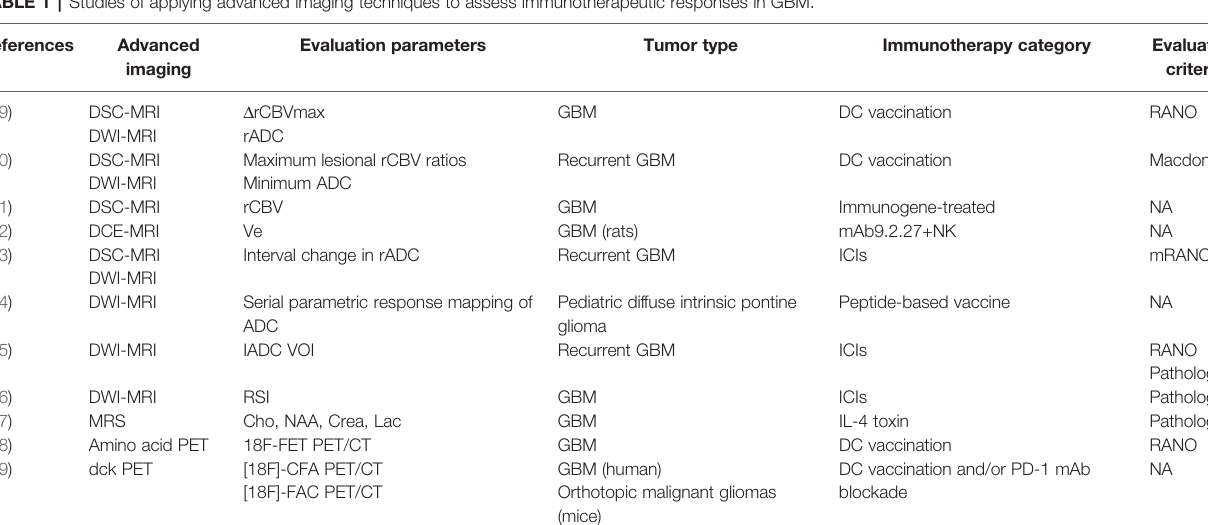
TABLE 1 | Studies of applying advanced imaging techniques to assess immunotherapeutic responses in